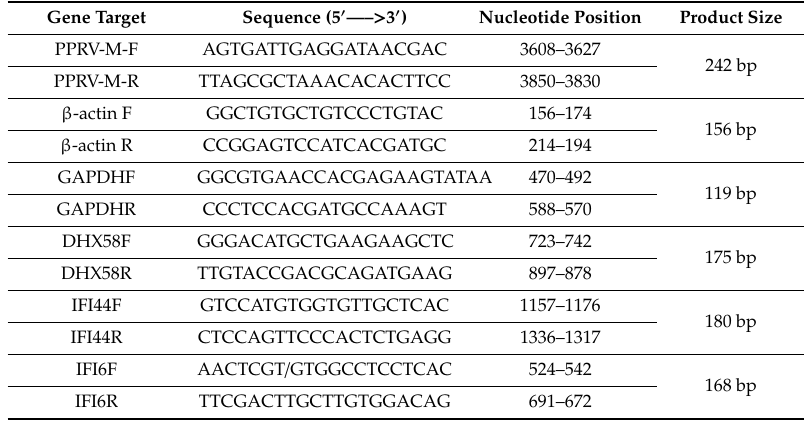
Table 1. The primer sequences, their location and the expected product size used for determining the expression levels of the gene targets in this